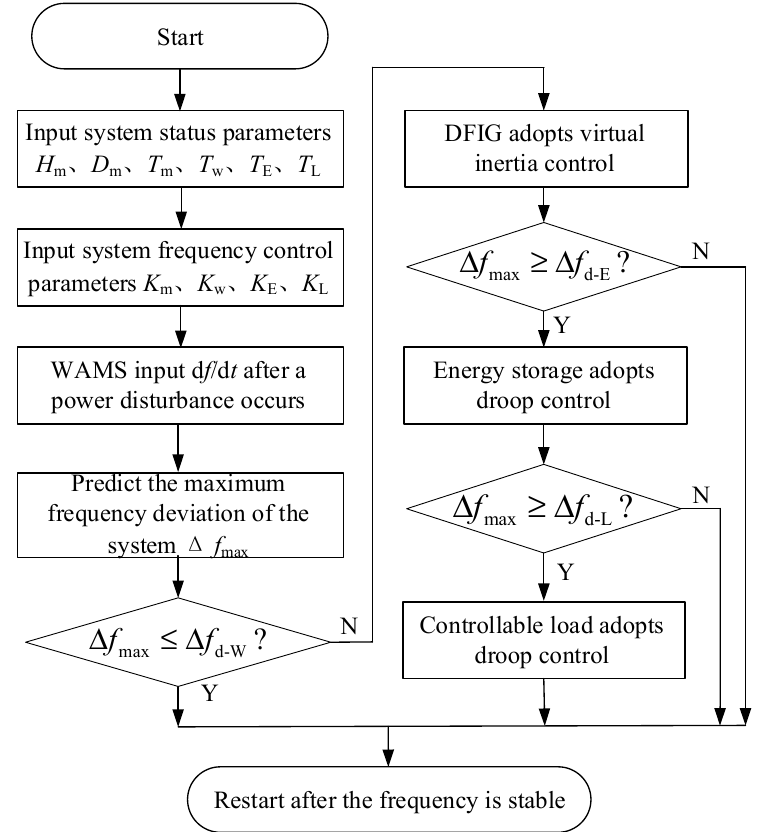
Figure 7. Flowchart of wind-storage-load cooperative control based on model prediction.